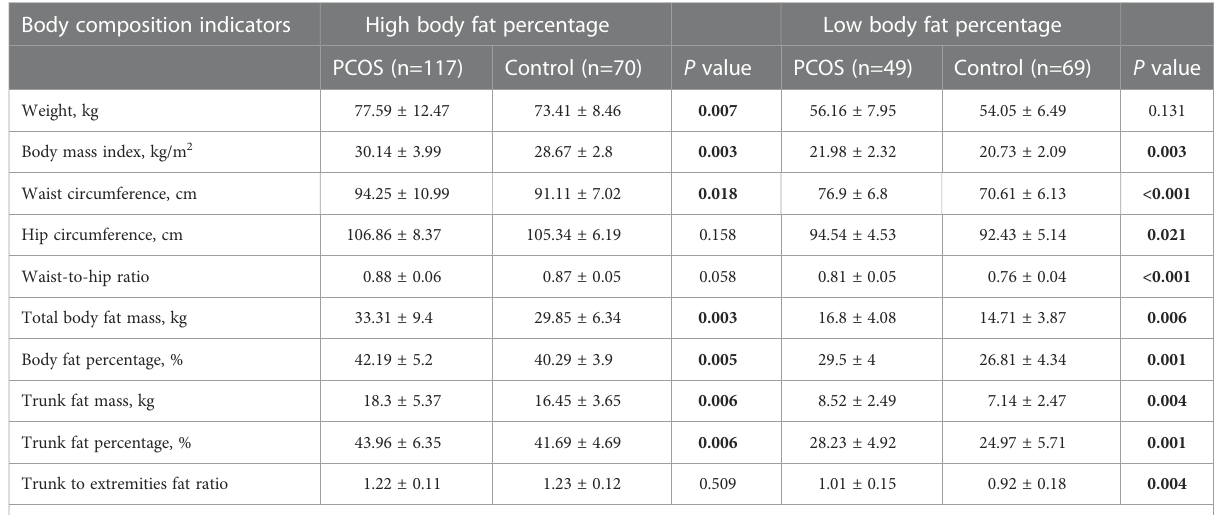
TABLE 4 Comparison of body composition indexes of PCOS and control groups after body fat percentage strati fi cation a . Body composition